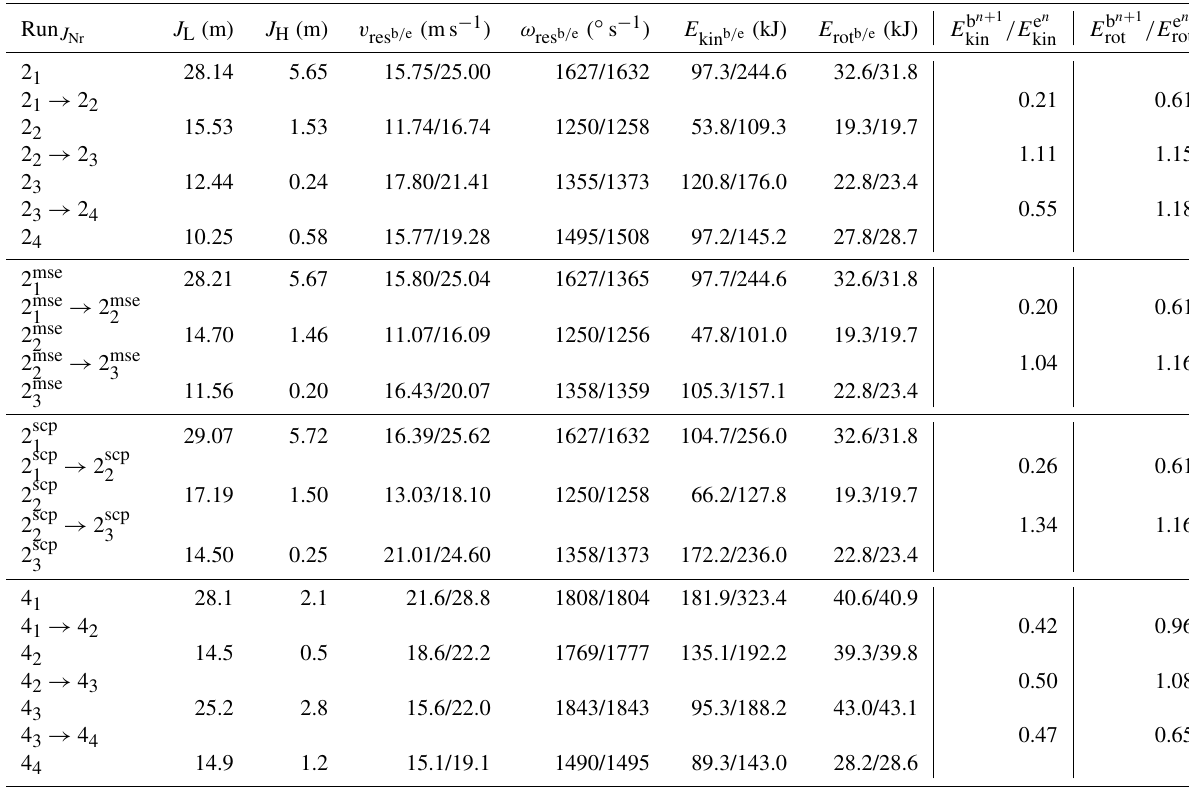
Table 2. Rockfall trajectory parameters of interest. Denoted are run number and the four jumps J Nr beginning with the cliff jump. Included are jump length J L , jump height J H , translational velocities v res , angular velocities ω res , kinetic E kin and rotational energies E rot at lift-off, and impact conditions denoted with superscripts b and e respectively. The last two columns summarize kinetic, E b n + 1 e n rotational energy transition, E b n rot , for the individual impacts. The transition from jump 2 1 rot /E + 1 = 1 corresponds to a perfectly elastic rebound /E e n that E b n kin kin